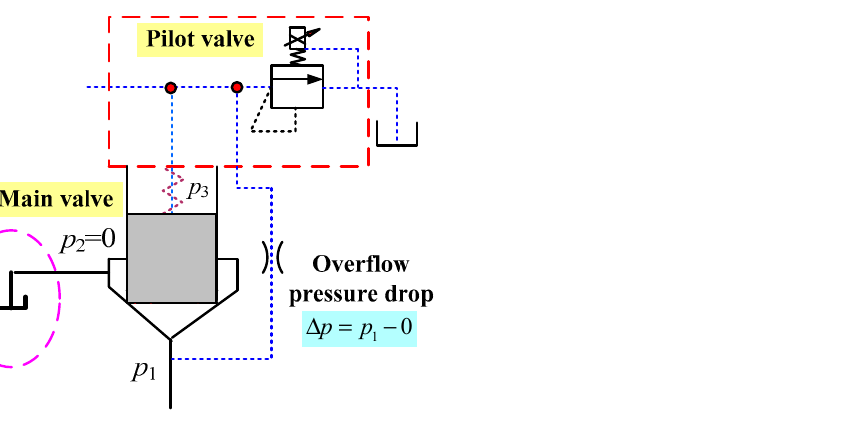
Figure 2. Working principle diagram of traditional proportional relief valve.